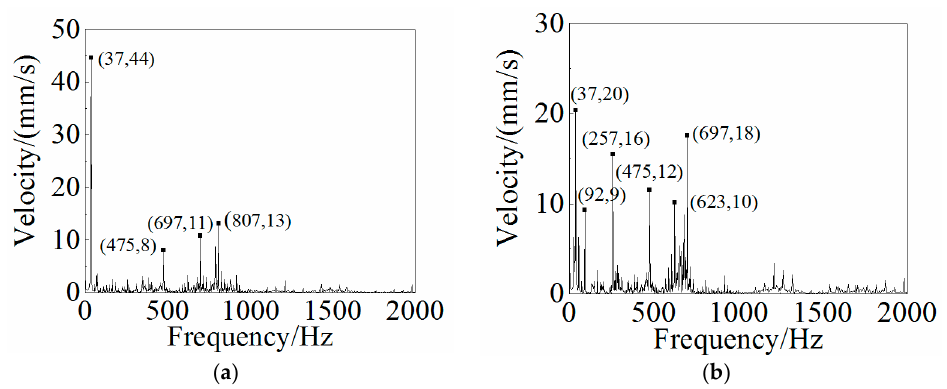
Figure 21. Frequency responses of ( a ) the isotropic and ( b ) the orthotropic oil cooler covers at Point 1 of Figure 20.